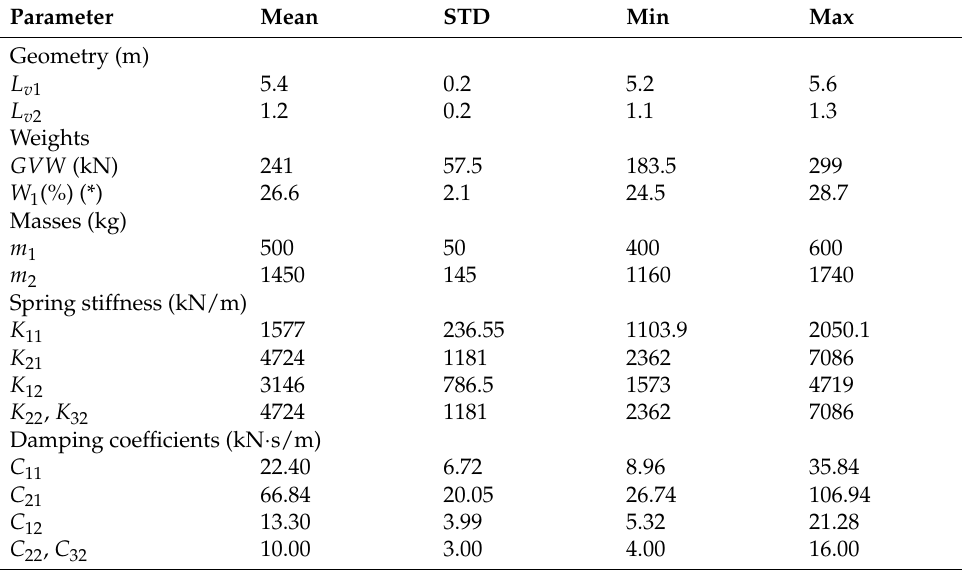
Table 3. Statistical distributions of vehicle parameters for the truck